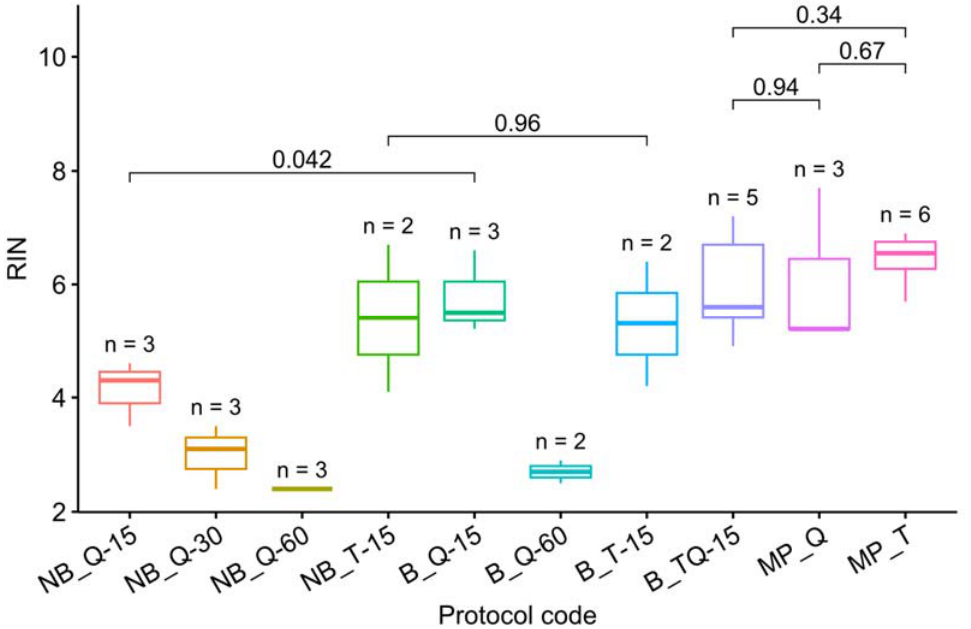
Figure 1. RIN visualization. The letters up to “_” denote the grinding method: MP–mortar and pestle, NB–Tissue Lyser without buffer, and B–with buffer. The following letters denote the isolation protocol: T–TRIzol, Q–RNEasy Plant Mini Kit, and TQ–a combination (Table 1). The number after “-” denotes the grinding time on the Tissue Lyser in seconds. The le tt er n marks the number of